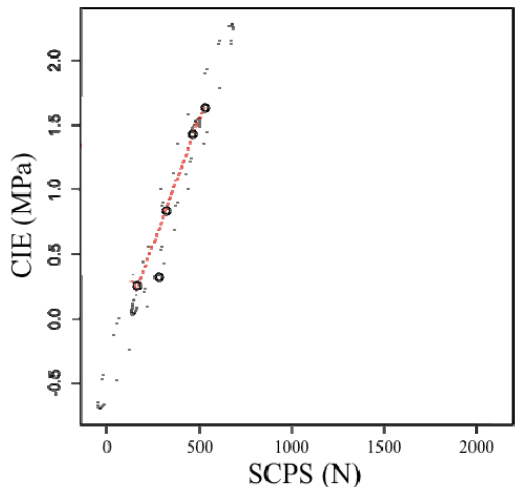
Figure 5. One-pass relationship between the profile-average cone index and the soil cutting